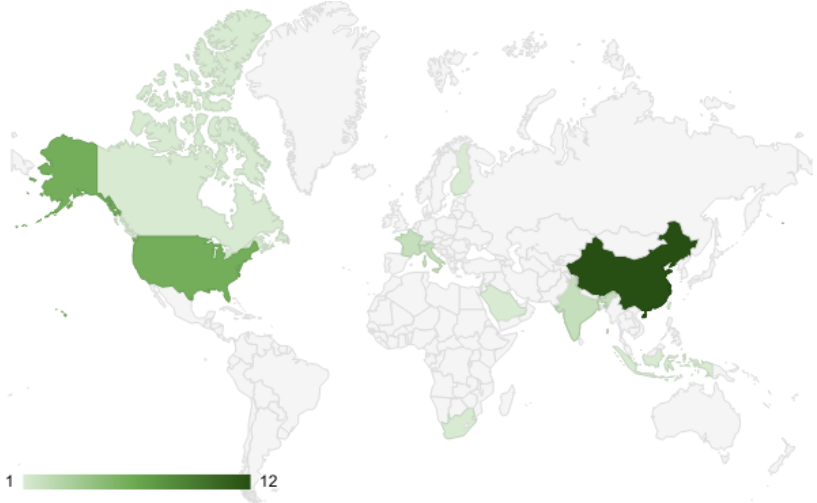
Figure 3. Degree of contribution of countries in Artificial Intelligence (NLP) in biomedical text